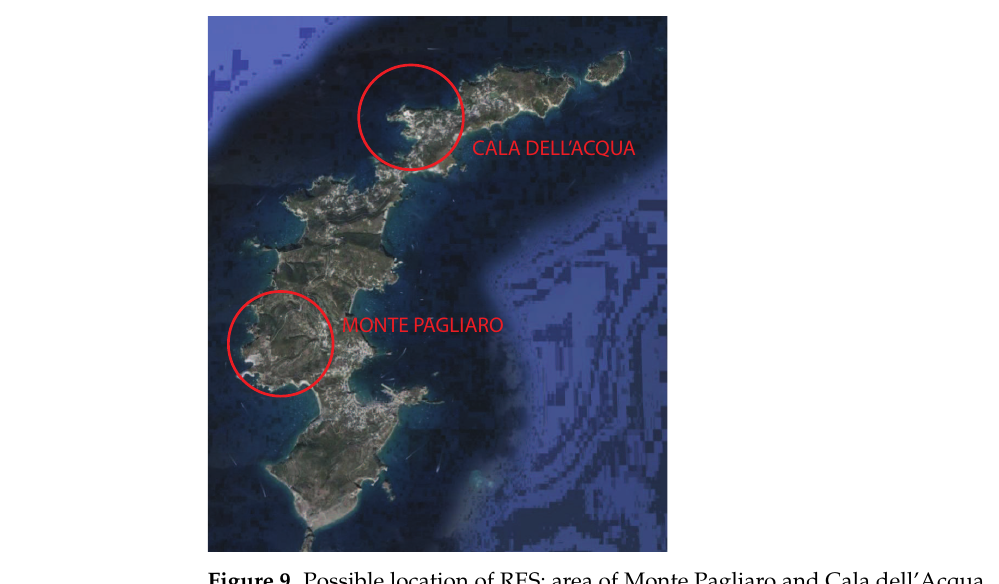
Figure 9. Possible location of RES: area of Monte Pagliaro and Cala dell’Acqua. Table 9. Electric power from RES [kWe] according to the objectives of the